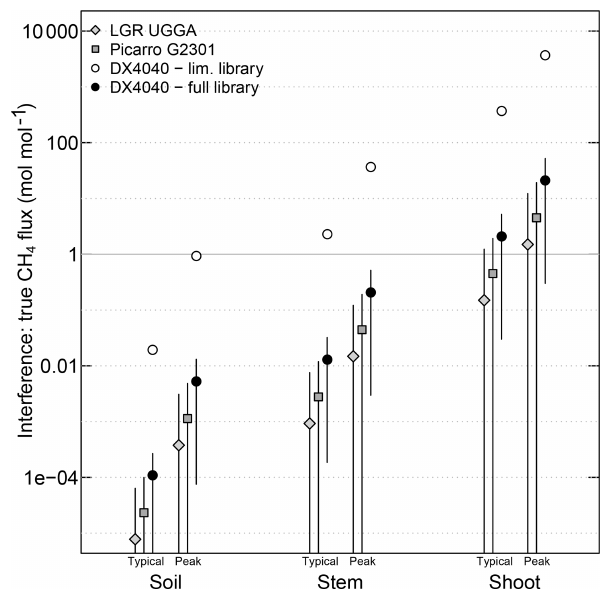
Figure 7. Estimated size of the CH 4 flux measurement error due to VOC interference (at typical and peak VOC fluxes) relative to the mean actual CH 4 fluxes in soil, stem, and shoot chambers. As- sumptions underlying these estimates are shown in Table 1. Only monoterpenes ( m/z 137 in PTR-MS measurements) were taken into account for this estimate, and it was assumed that all monoter- penes interfere with CH 4 analysers at the same rate as β -pinene. The results presented here should therefore be understood as order- of-magnitude estimates. Symbols indicate medians with error bars indicate the analytical uncertainty (95% confidence interval) asso- ciated with the quantification of VOC interferences, but do not take into account uncertainties in other